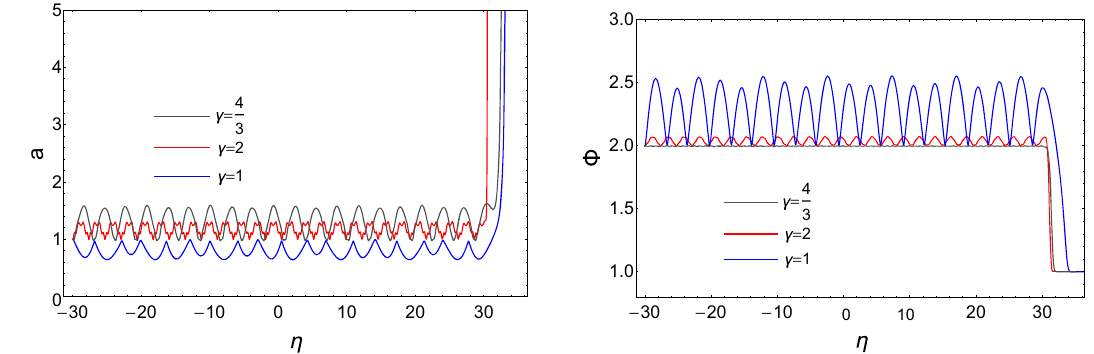
Fig. 9 Dynamical evolution of scale factor (left panel) and the BD scalar field (right panel) for the same model parameters as specified in Figs. 3, 4, 5 but slightly different initial values. We have set the parameters of the expression for EoS departure as γ 1 = 0 . 001, α = 1 and η 0 = 30 ,